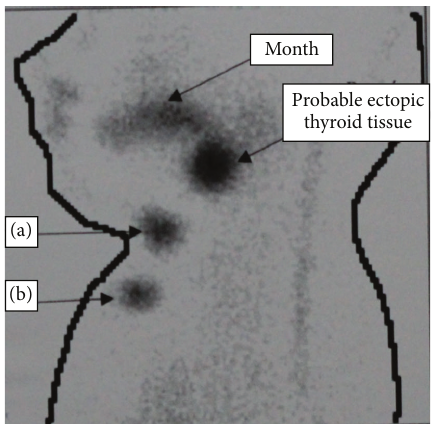
Figure 2: Scintigraphy interpretation. (a) Cricoid cartilage, (b) sternal furculum. Absence of uptake in the thyroid bed (anterior neck) with probable location at the base of the tongue, suggestive of ectopic